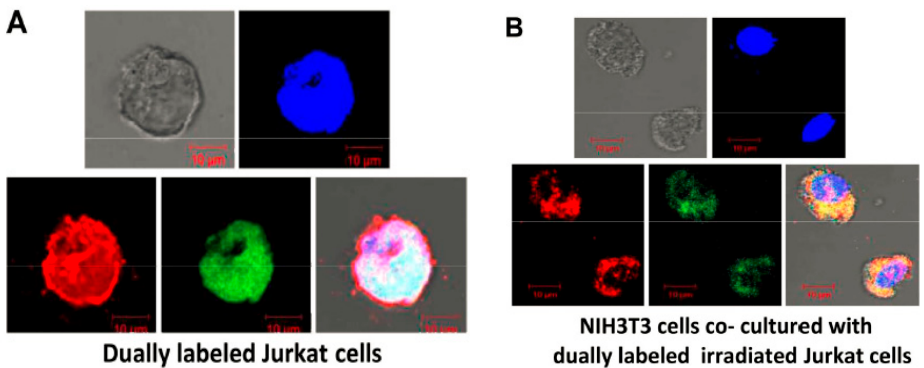
Figure 5. Confocal microscopy images to demonstrate bystander uptake by NIH3T3 cells of dually labeled cfCh particles released from irradiated dying Jurkat cells that had been labeled in their DNA with BrdU (red) and histones by CellLight ® Histone 2B-GFP (green). ( A ). dually labeled Jurkat cells. ( B ). NIH3T3 cells that had been co-cultivated with irradiated (15 Gy) dually labeled Jurkat cells at 24 h. Reproduced from [84].